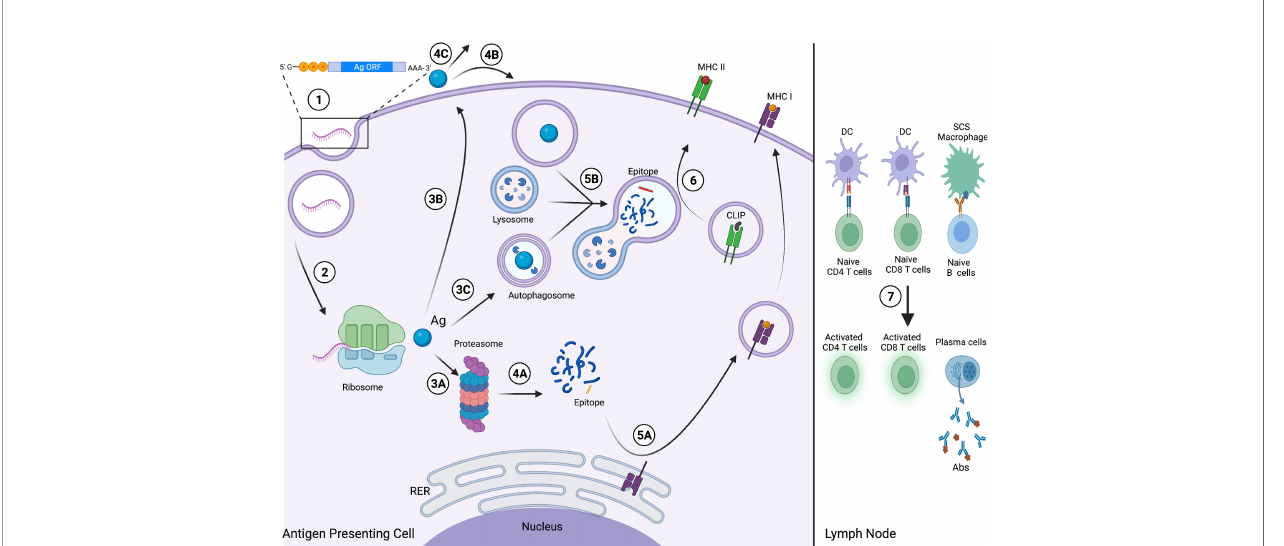
FIGURE 1 | Viral and Cancer RNA vaccine mechanism. (1) The viral Ag, TAA or TSA-encoding mRNA enters the APC and then the cytosol following endosomal escape. (2) The mRNA is translated by the host ribosomal machinery into the encoded Ag, which is then either (3A) degraded by the proteasome and enters the endogenous MHC I pathway; (3B) exocytosed from the APC via the secretory pathway; or (3C) enters the autophagic pathway and is internalized by an autophagosome. (4A) Proteasome-mediated degradation yields fragments (blue), including the epitope (yellow). Following secretion, the Ag either (4B) enters an APC via endocytosis and then the exogenous MHC II pathway; or (4C) the native antigen will circulate through the lymphatic system to secondary lymphoid organs. (5A) The epitope binds MHC I at the rough endoplasmic reticulum (RER) and traf fi cs to the cell membrane for surface presentation via the secretory pathway. (5B) The Ag, internalized via endocytosis or processed by autophagy, is digested into fragments, including the epitope (red), via lysosome-mediated degradation. (6) The epitope binds MHC II and displaces class-II associated invariant chain peptide (CLIP), and the complex then traf fi cs to the membrane for surface presentation. (7) The APCs migrate to secondary lymphoid organs, including the lymph node. The APCs present the epitope-loaded MHC I and MHC II complexes to activate naive CD8 and CD4 T cells, respectively, and follicular DCs and subcapsular sinus (SCS) macrophages present the native Ag to activate naive B cells, driving plasma cell differentiation and Ab production. This fi gure was created with